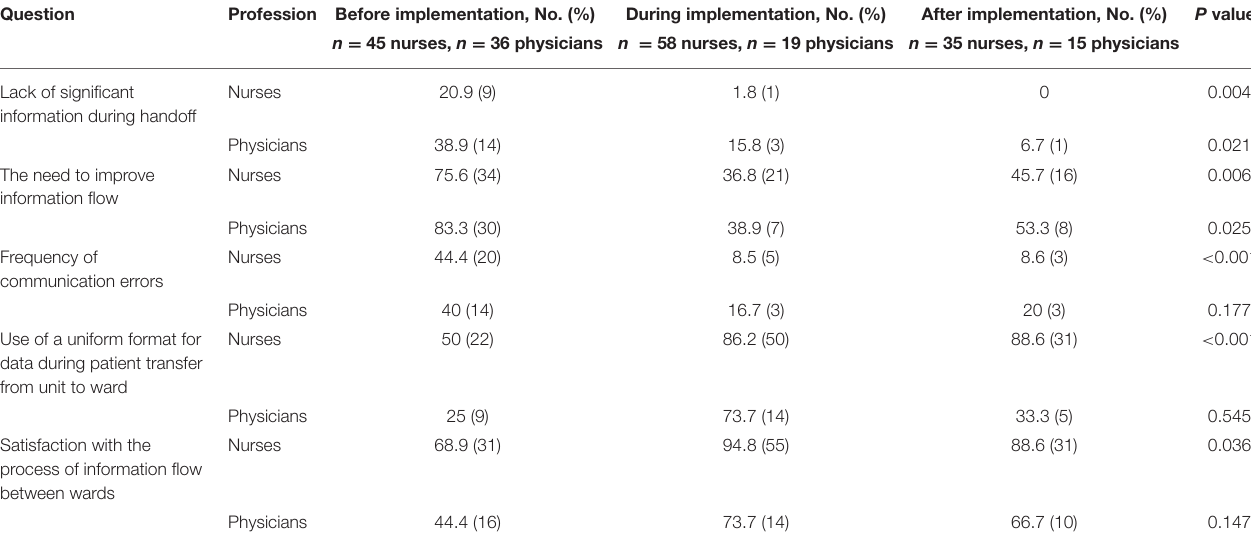
TABLE 2 | Comparison between physicians and nurses who indicated high or very high project satisfaction before and after project implementation. Question Profession Before implementation, No. (%) During implementation, No. (%) After implementation, No.